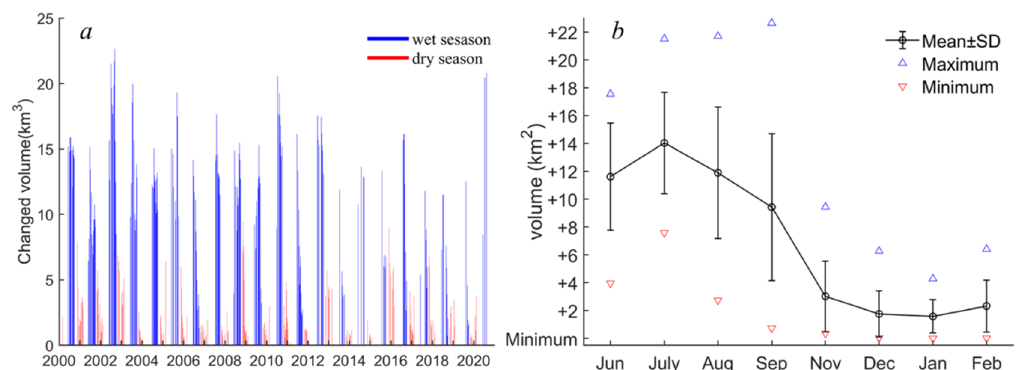
Figure 10. Lake storage changes in wet and dry seasons on a monthly scale ( a ) and their seasonal variations ( b ). The red bars in ( a ) indicate the changed volumes in the dry seasons, and the blue bars indicate those in the wet seasons. Because the volume under the smallest inundated area during 2000–2020 was unknown, the unknown volume was considered as the minimum in ( b ).